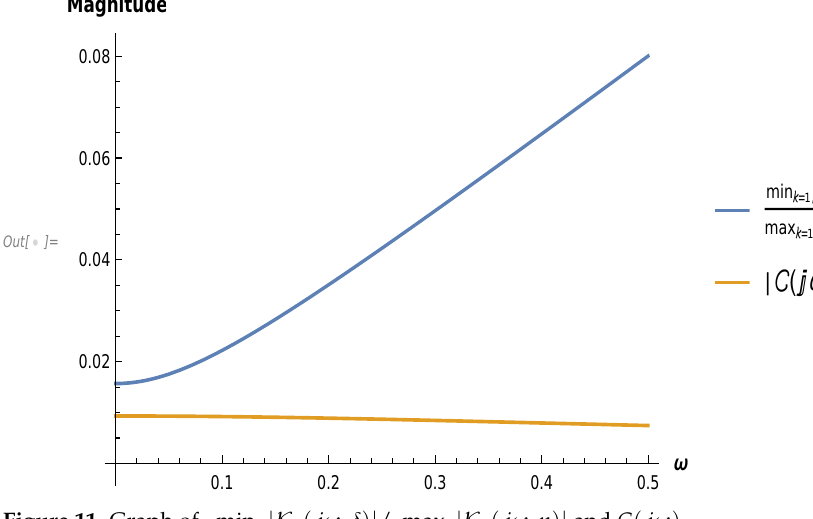
Figure 11. Graph of min